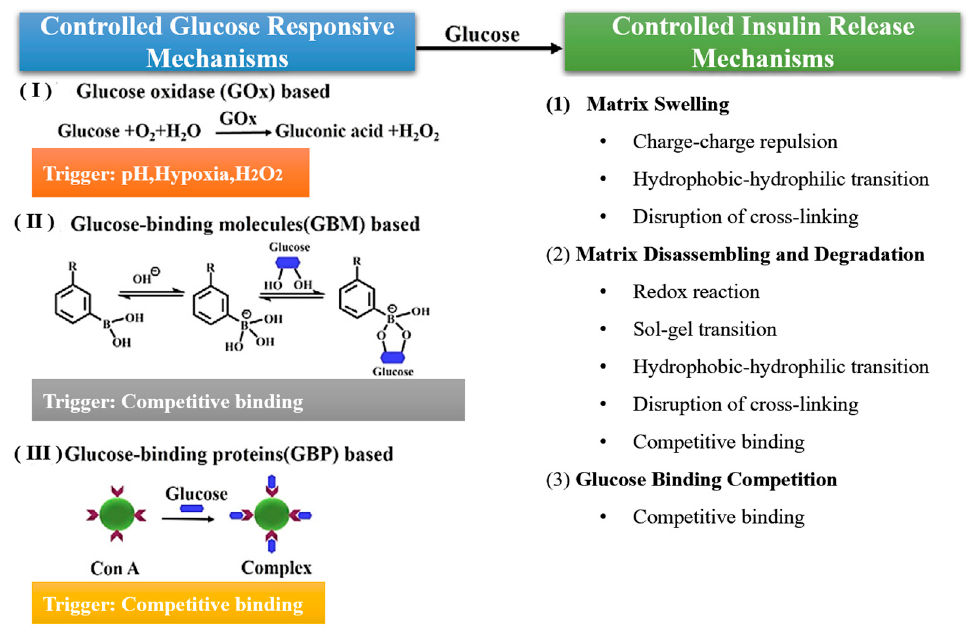
Figure 7. Illustration of the mechanisms employed to achieve chemically controlled closed-loop systems for insulin release (adapted with modifications from Reference [102]).